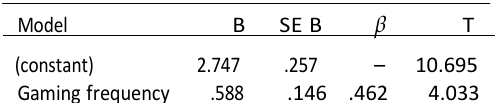
Table 2. Linear regression table for behavioral intention based on independent and explanatory variables.